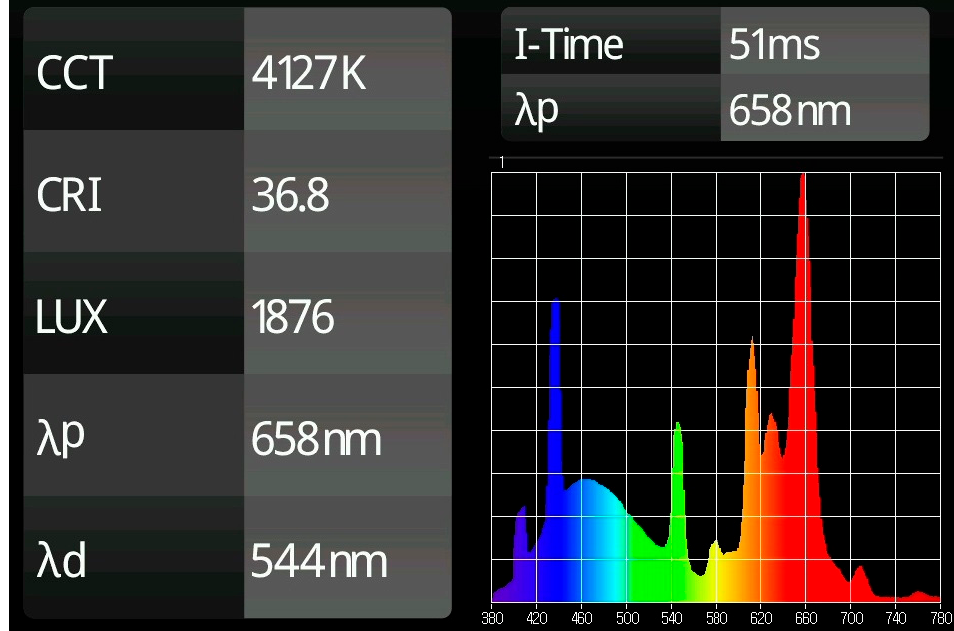
Figure 1. Spectral diagram and values of light characterization of the emission of a Grolux fluores- cent tube. Table 3. Range of energy losses depending on the type of auxiliary ballast of fluorescent lamps.